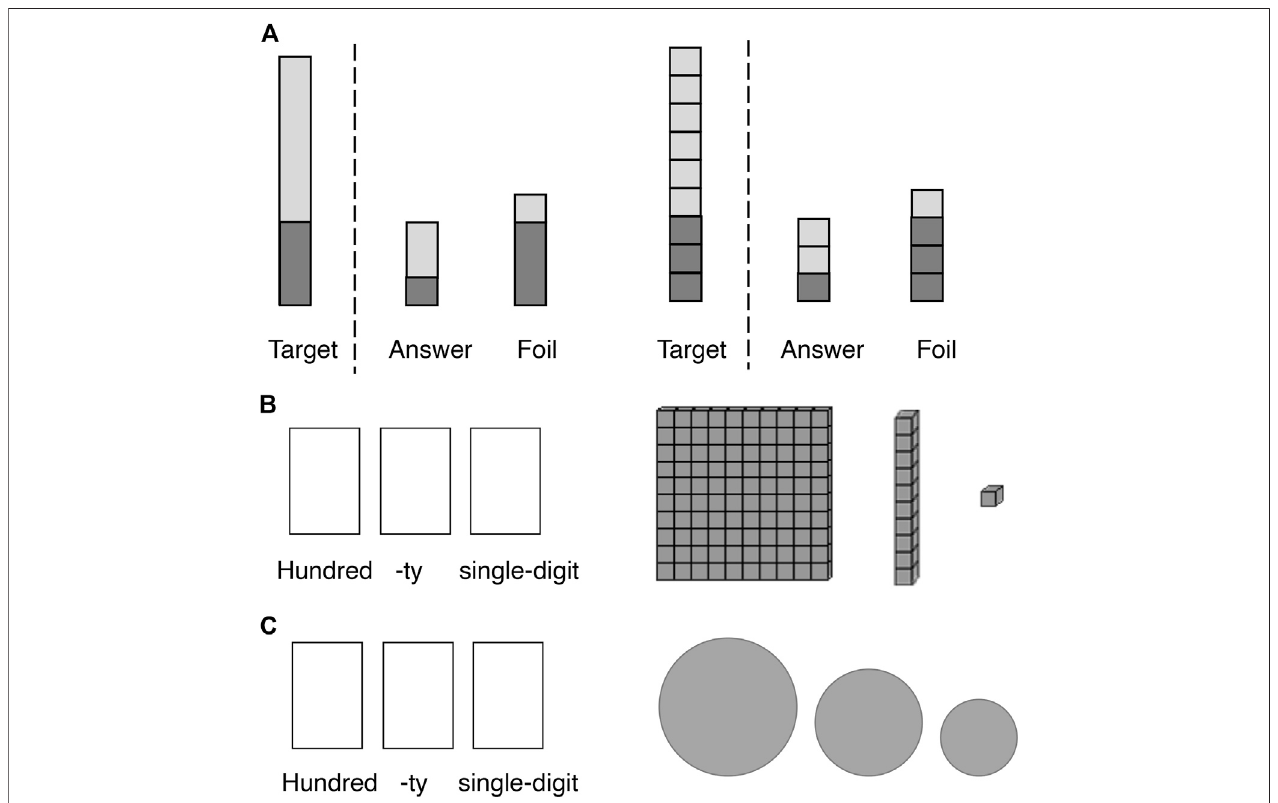
FIGURE 6 | How discrete presentation draws attention to individual units rather than relational patterns and how to better highlight the relational structure of place value. (A) Left: the continuous presentation format, Right: the discrete presentation format used in a proportional reasoning task (Boyer et al., 2008). (B) How base-10 blocks represent the relational structure of place value. (C) How simple shapes (e.g., big, medium, and small discs) represent the relational structure of place